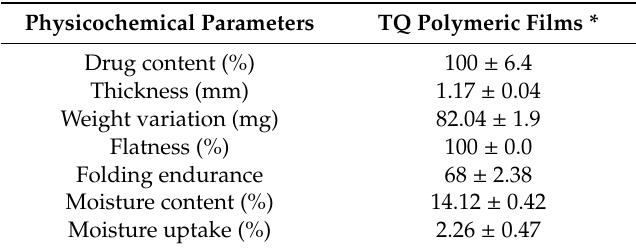
* Data show mean of five determinations with ± standard